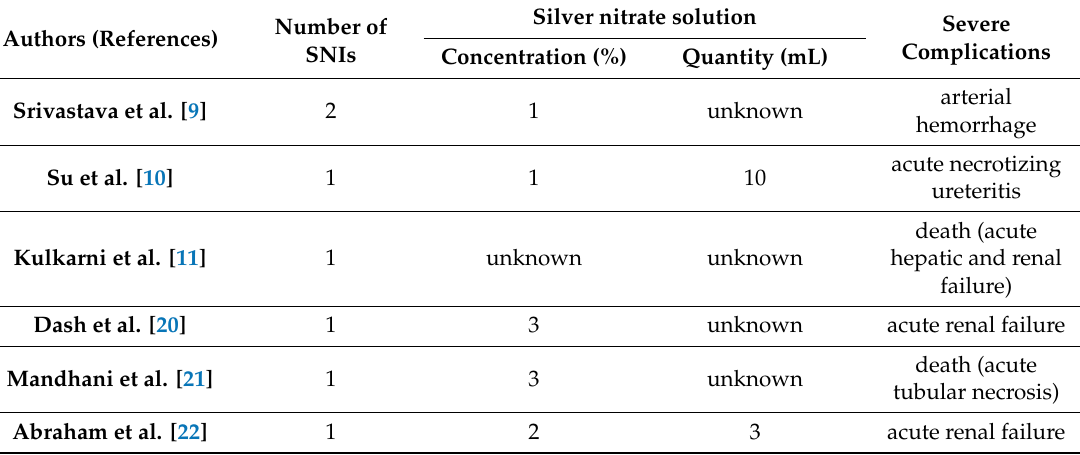
Table 4. List of cases with severe life-threatening